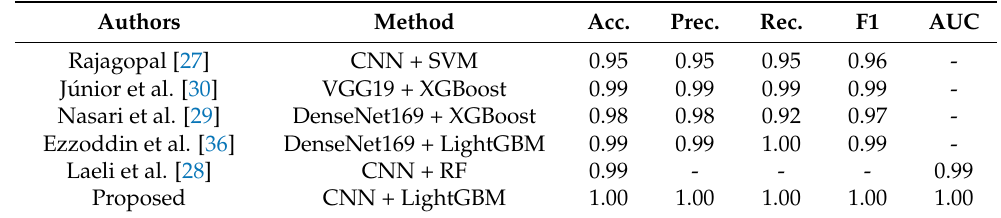
Table 2. Results compared to other state-of-the-art methods, namely accuracy, precision, recall, F1-score and AUC. The results not provided by the authors are marked with ‘-’. Authors Method Acc. Prec. Rec.